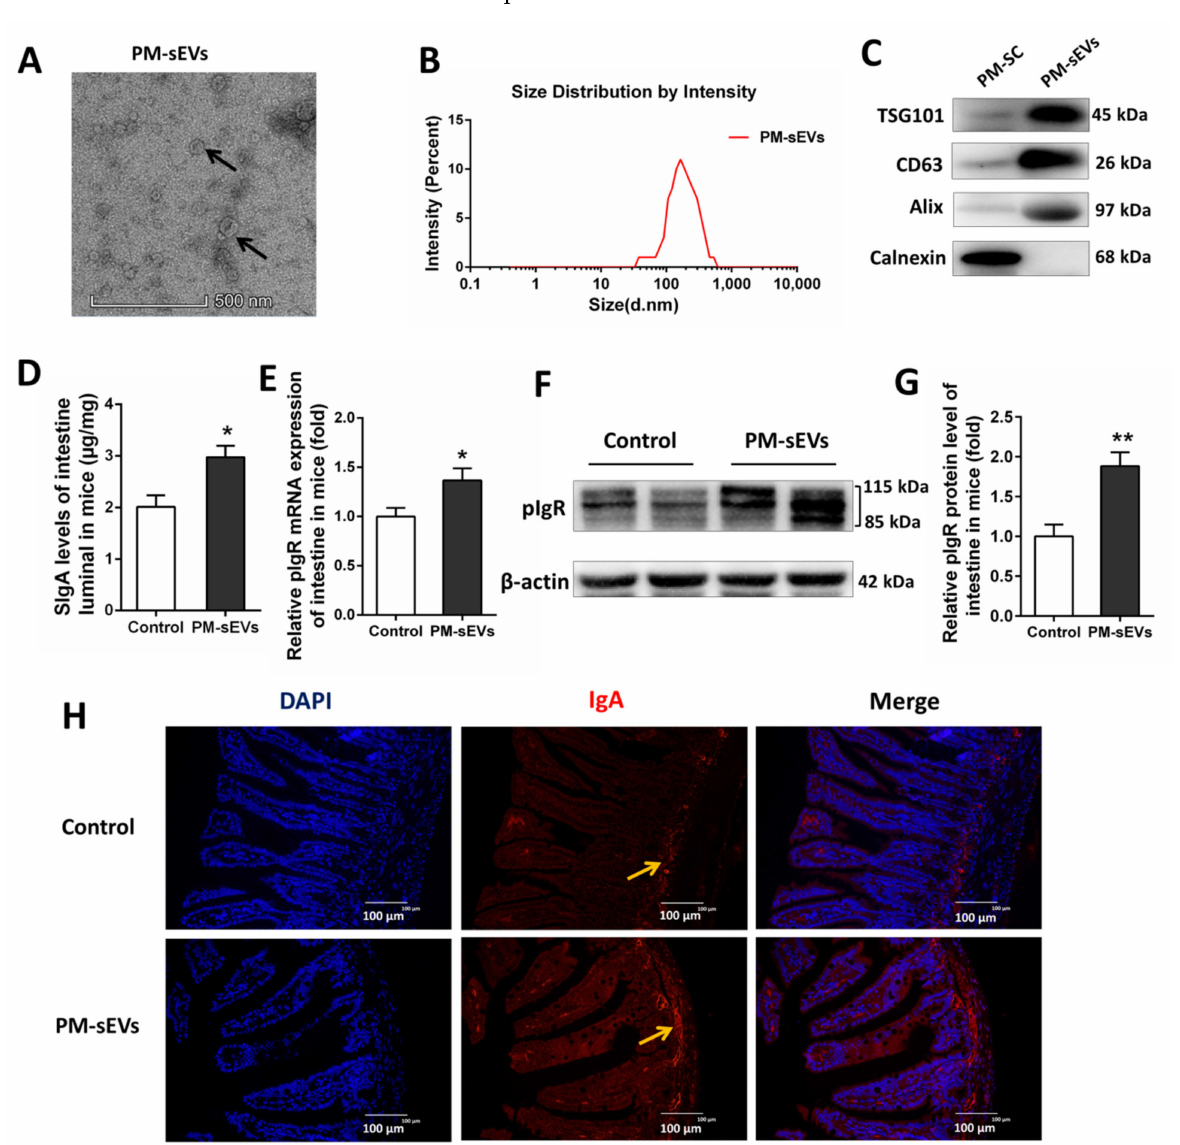
Figure 1. Identification of PM-sEVs and effect of PM-sEVs on intestinal SIgA levels in mice. ( A ) Morphology of PM-sEVs visualized under TEM. Scale bar: 500 nm. The arrows indicate “PM-sEVs”. ( B ) Size distribution analysis of PM-sEVs. ( C ) Western Blotting analysis of porcine milk somatic cell (PM-SC) and PM-sEVs. Milk SC and PM-sEVs were blotted for commonly used sEVs markers TSG101, CD63, and Alix and the endoplasmic reticulum marker Calnexin. ( D ) ELISA analysis of SIgA levels of intestinal luminal contents in mice ( n = 8). ( E ) qRT-PCR analysis of pIgR mRNA expression levels of intestinal tissue in mice ( n = 8). ( F , G ) Western Blotting analysis of pIgR protein level of intestinal tissue in mice ( n = 4). ( H ) Intestine of mice was sectioned for immunofluorescence staining (Scale bar = 100 µ m) to analysis the level of IgA ( n = 4). All data are presented as means ± SEM. * p < 0.05; ** p <